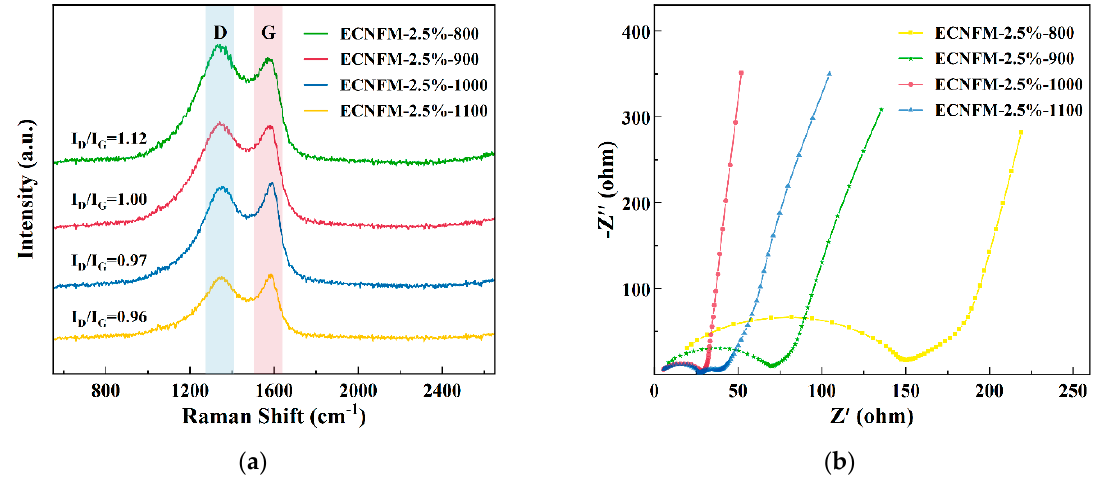
Figure 5. ( a ) Raman spectra and ( b ) EIS plot of ECNFM-2.5%-T (T = 800, 900, 1000, 1100 °C).